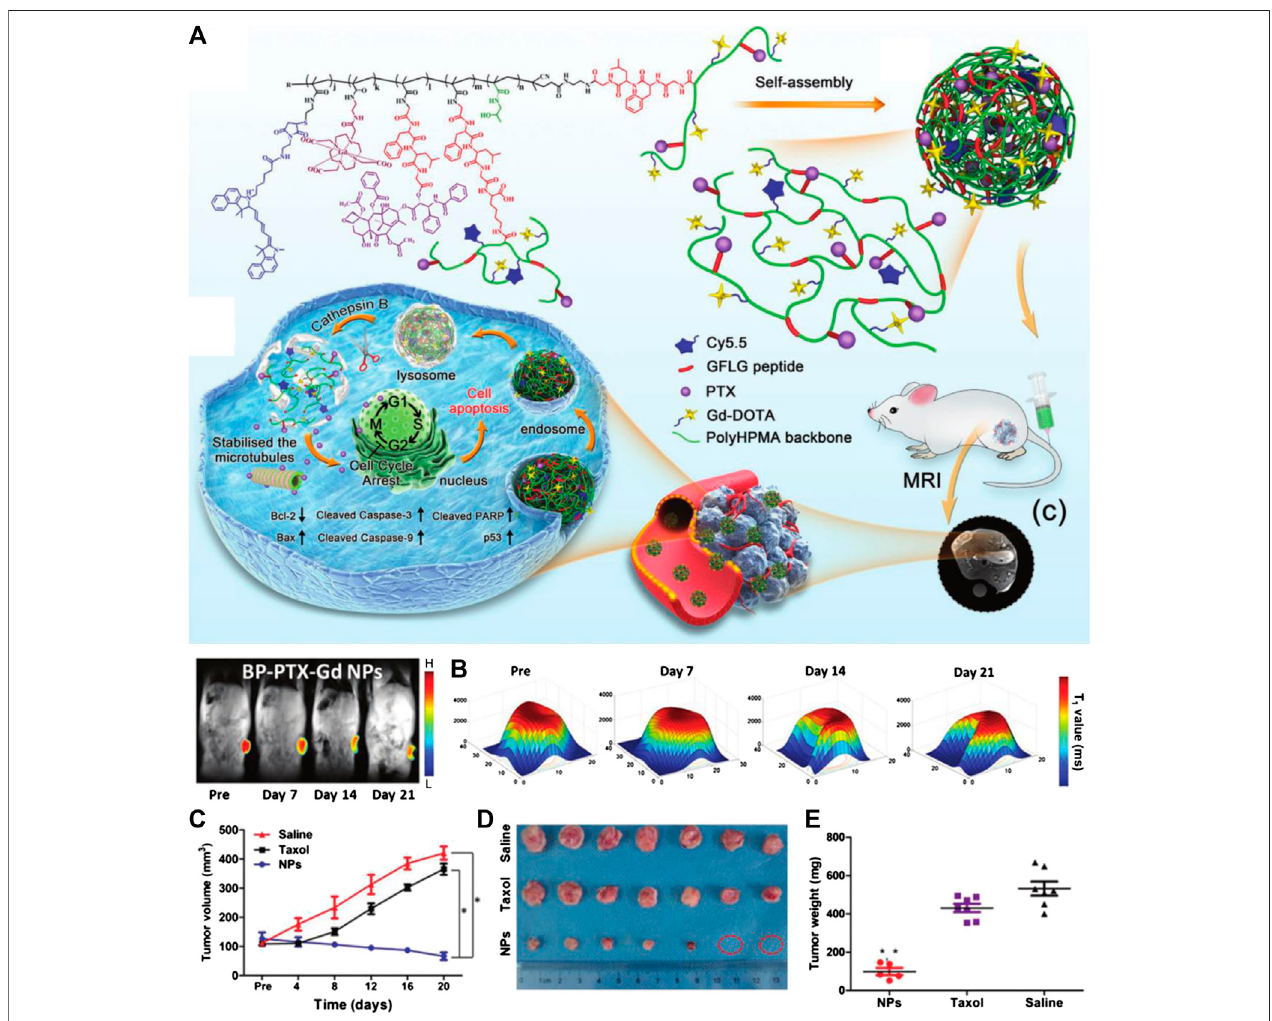
FIGURE 1 | (A) Schematic illustration of cathepsin B-responsive biodegradable theranostic nanomedicine derived from branched pHPMA. (B) Distribution of T 1 valueof tumor at different time points after injection. (C) Quantitative tumor volume changes ofmice obtained by MRI after being treated with saline, Taxol,and BP-PTX- GdNPs( n (cid:2) 7,* p < 0.001vs.saline, * p < 0.001vs.Taxol). (D) Imagesofthetumorsharvestedfromthemice21 daysafterthetreatment. (E) Thetumorweightoftumor- bearing mice after treatment (* p < 0.001 vs. saline, * p < 0.001 vs. Taxol). Reproduced with permission from Cai H. et al. (2020). Copyright 2020 Wiley-VCH Verlag GmbH & Co.